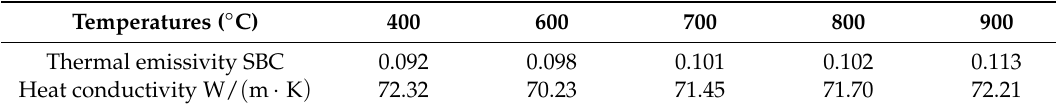
Table 8. Thermal contact parameters at different temperatures.